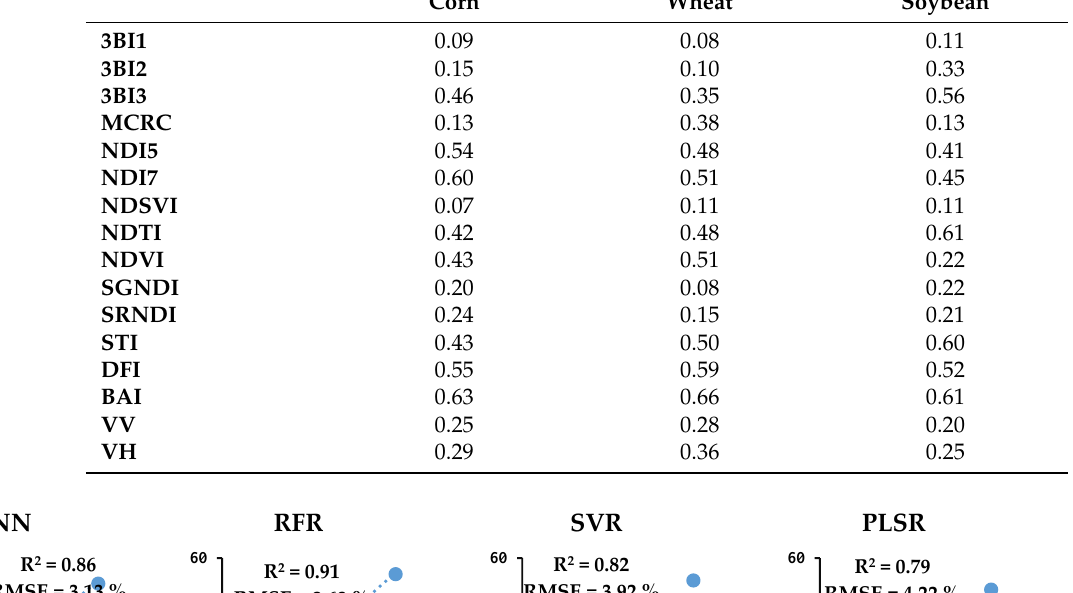
Table 2. The R 2 between the effective variables and the residues for different crops. Corn Wheat